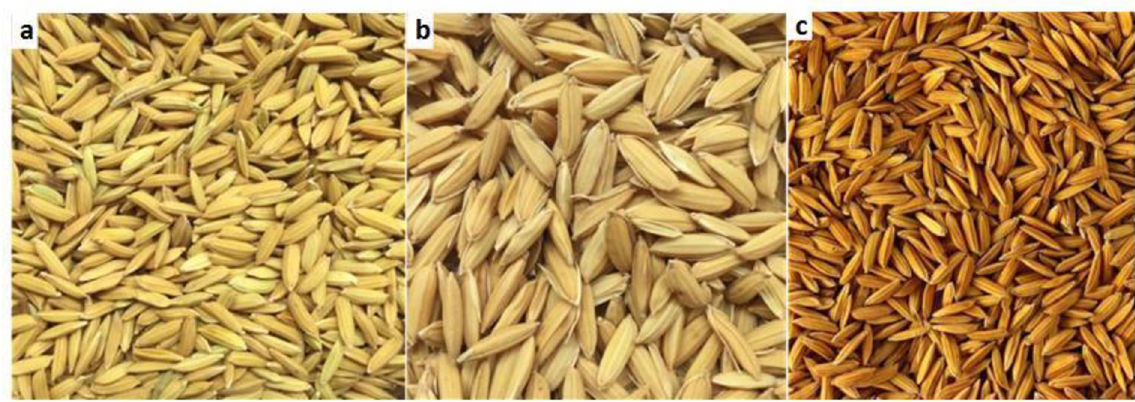
Fig 4. Most preferred rice verities used to process pepeta mentioned by respondents in the study area. a) TXD306/SARO 5, b) Mbawambili, and c) Kalamata. Source: Survey data, September 2017 –February 2018.